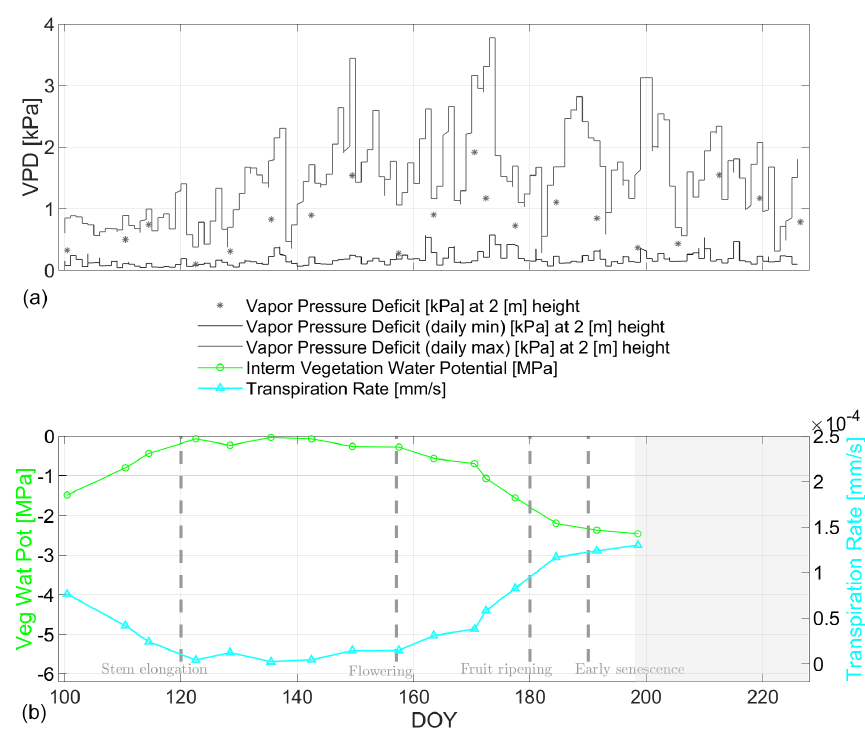
Figure 14. (a) Minimum and maximum of the vapor pressure deficit (VPD) [kPa] for atmospheric water need shown with gray lines. The asterisks indicate the VPD values at time of radiometer measurement. The x -axis labels are the same as for (b) . Bottom: Comparison of radiometer-based transpiration rates TR [mms − 1 ](cyan curve for variable canopy and aerodynamic resistances as well as a fixed cuticular resistance) and vegetation water potential (green curve) VWP [MPa] along the growing period of 2017 for days of year (DOY) at the winter wheat field in Selhausen, Germany. The gray-masked area indicates the senescence phase where the assumption in the stomatal resistance calculus is not applicable. Vertical dashed lines indicate major phenological phases of the winter